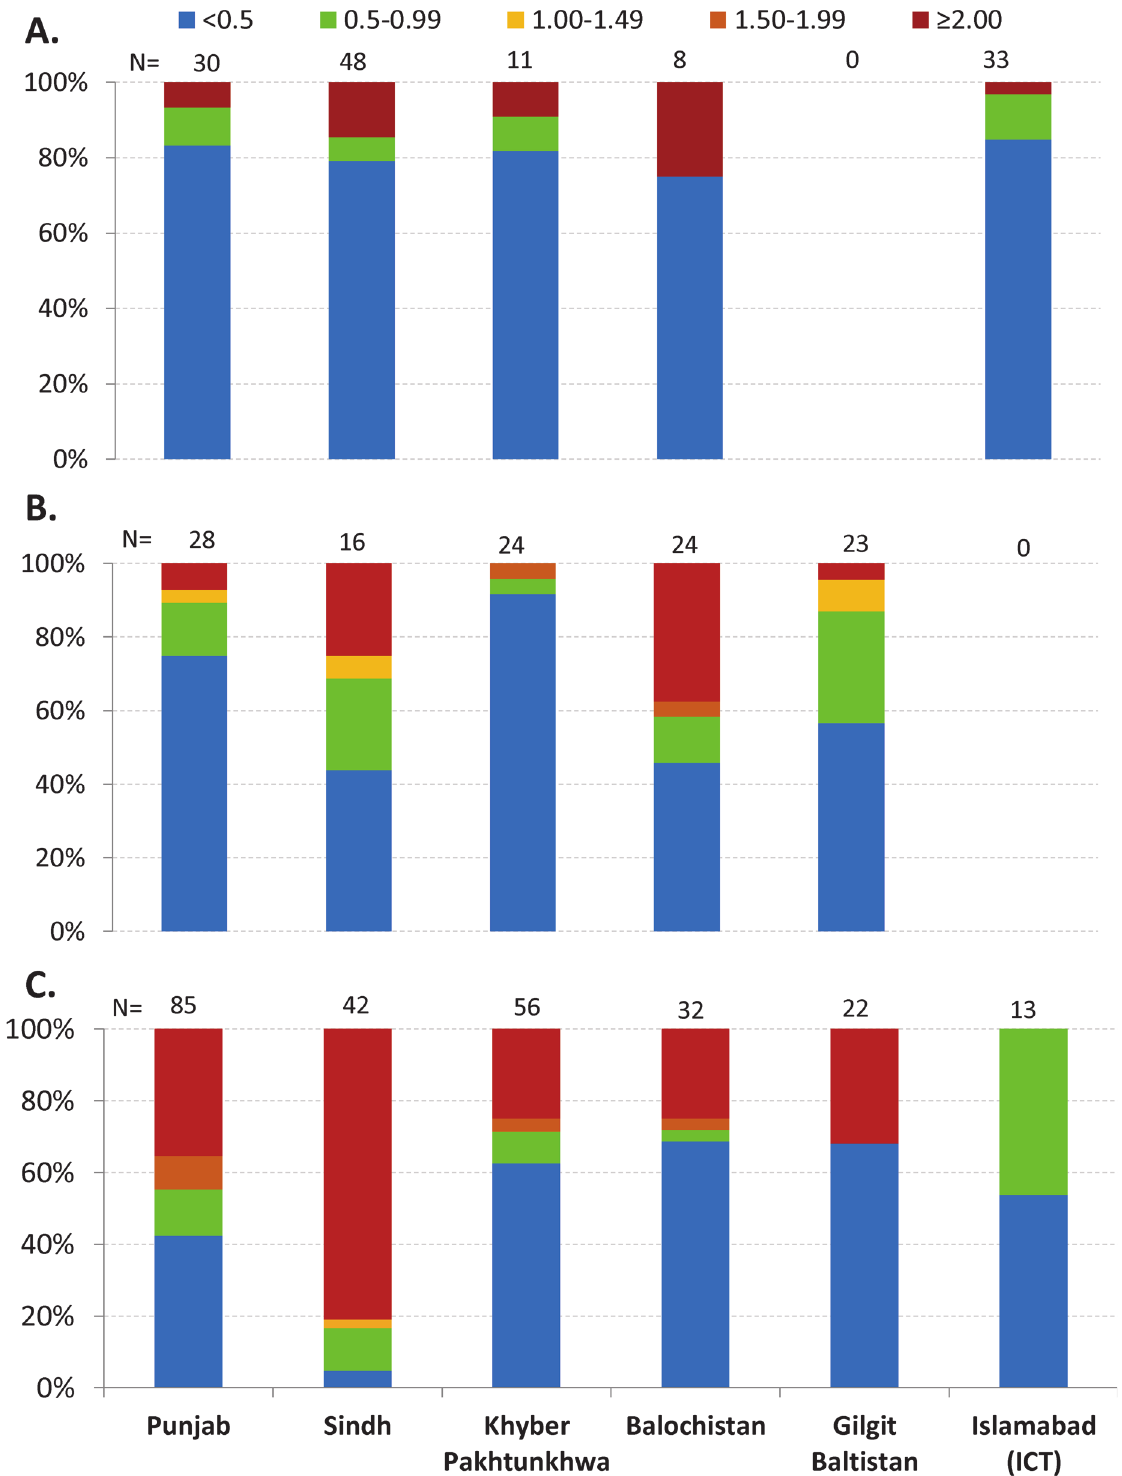
Fig 1. Distribution of ratio of probability of being under-weight to obese at community level by urbanization level, DHS Pakistan 2012 – 13. A: Major Urban; B: Small City and C: Rural. Ratio of 1 denotes equal percentage of underweight and obesity, below 1 indicates higher obesity and above 1 indicates higher percentage of underweight within a